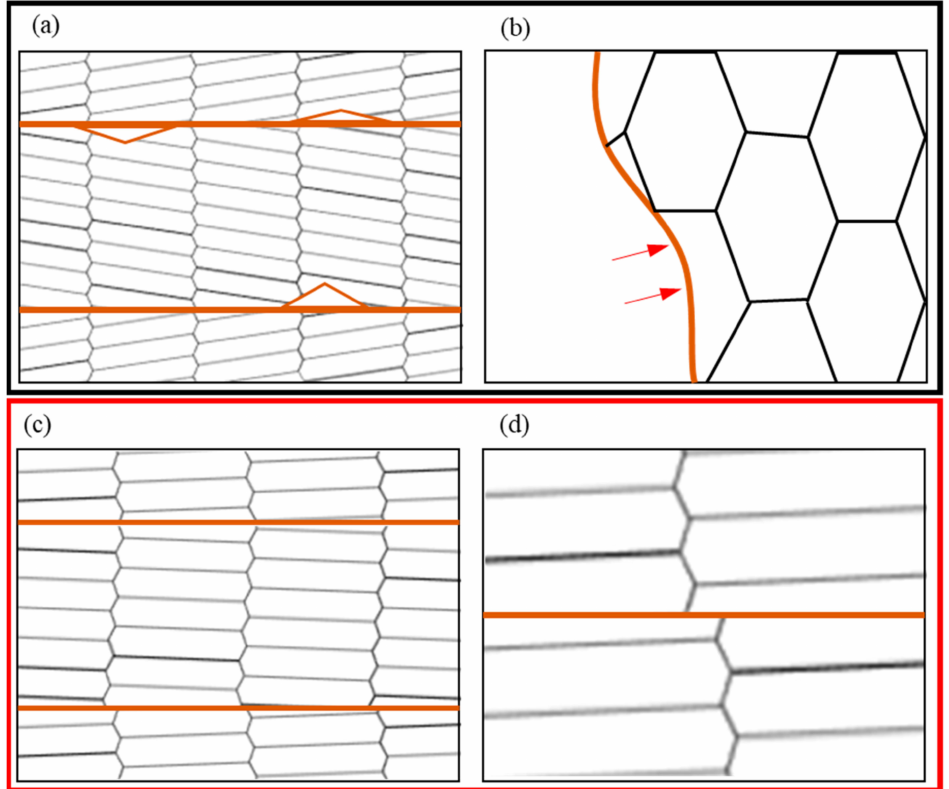
Figure 7. Schematic diagram of grain growth. ( a , b ) Discontinuous recrystallization processes: ( a ) serious lattice distortion and grain boundary arched nucleation; ( b ) grain growth. ( c , d ) Continu- ous recrystallization processes: ( c ) dislocations in grain recovery and subgrain boundary rotation; ( d ) slowly weakening lattice distortion with grain growth. The brown lines indicate subgrain bound- aries and grain boundaries, and the black grid indicates the degree of lattice